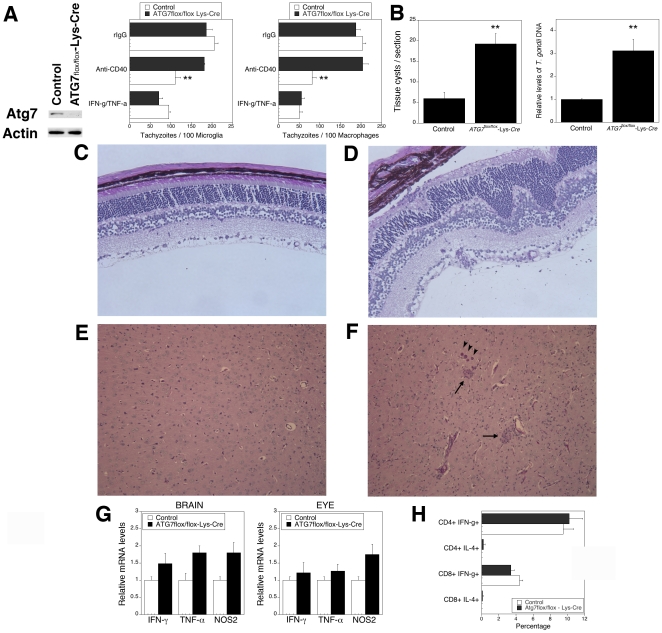
Mice deficient in autophagy in macrophages/microglia are susceptible to toxoplasmosis.
A, Primary microglia and macrophages were obtained from control and ATG7flox/flox-Lyz-Cre mice. Atg7 and actin expression were assessed by immunoblot. Results shown are those obtained with microglia. Similar findings were observed in primary macrophages. Microglia and macrophages were incubated with a stimulatory anti-CD40 or control mAb, or with IFN-γ/TNF-α followed by infection with tachyzoites of RH T. gondii. B–F, ATG7flox/flox-Lyz-Cre and control mice were infected with ME49 T. gondii. Mice (4–5 mice per group) were euthanized at 3 weeks post-infection. B, ATG7flox/flox-Lyz-Cre mice exhibit higher parasite load in the eye and brain than control mice. Numbers of tissue cysts were determined in 100 high power fields. C, D, Compared to control mice (C), infected ATG7flox/flox-Lyz-Cre mice (D) revealed more prominent disruption of retinal architecture and inflammation. PASH; X200. E, F, Compared to control mice (E), infected ATG7flox/flox-Lyz-Cre mice (F) show more prominent areas of inflammation (arrow) and frequent tissue cysts (arrow head) in the brain. PASH X100. G, Eyes and brains were obtained at 3 weeks post-infection and used to isolate RNA. Levels of IFN-γ, TNF-α and NOS2 mRNA were examined using real time quantitative PCR and normalized against the levels of 18s rRNA. Each group contained 5 mice. H, Splenocytes were obtained from control and ATG7flox/flox-Lyz-Cre mice 3 weeks post-infection with ME49 T. gondii and were incubated with TLA as described in Materials and Methods. The percentages of CD3+ CD4+ or CD3+ CD8+ T cells that became IFN-γ+ or IL-4+ cells were determined by flow cytometry. Results are shown as the mean ± SEM and are representative of 3 independent experiments. **p≤0.01.